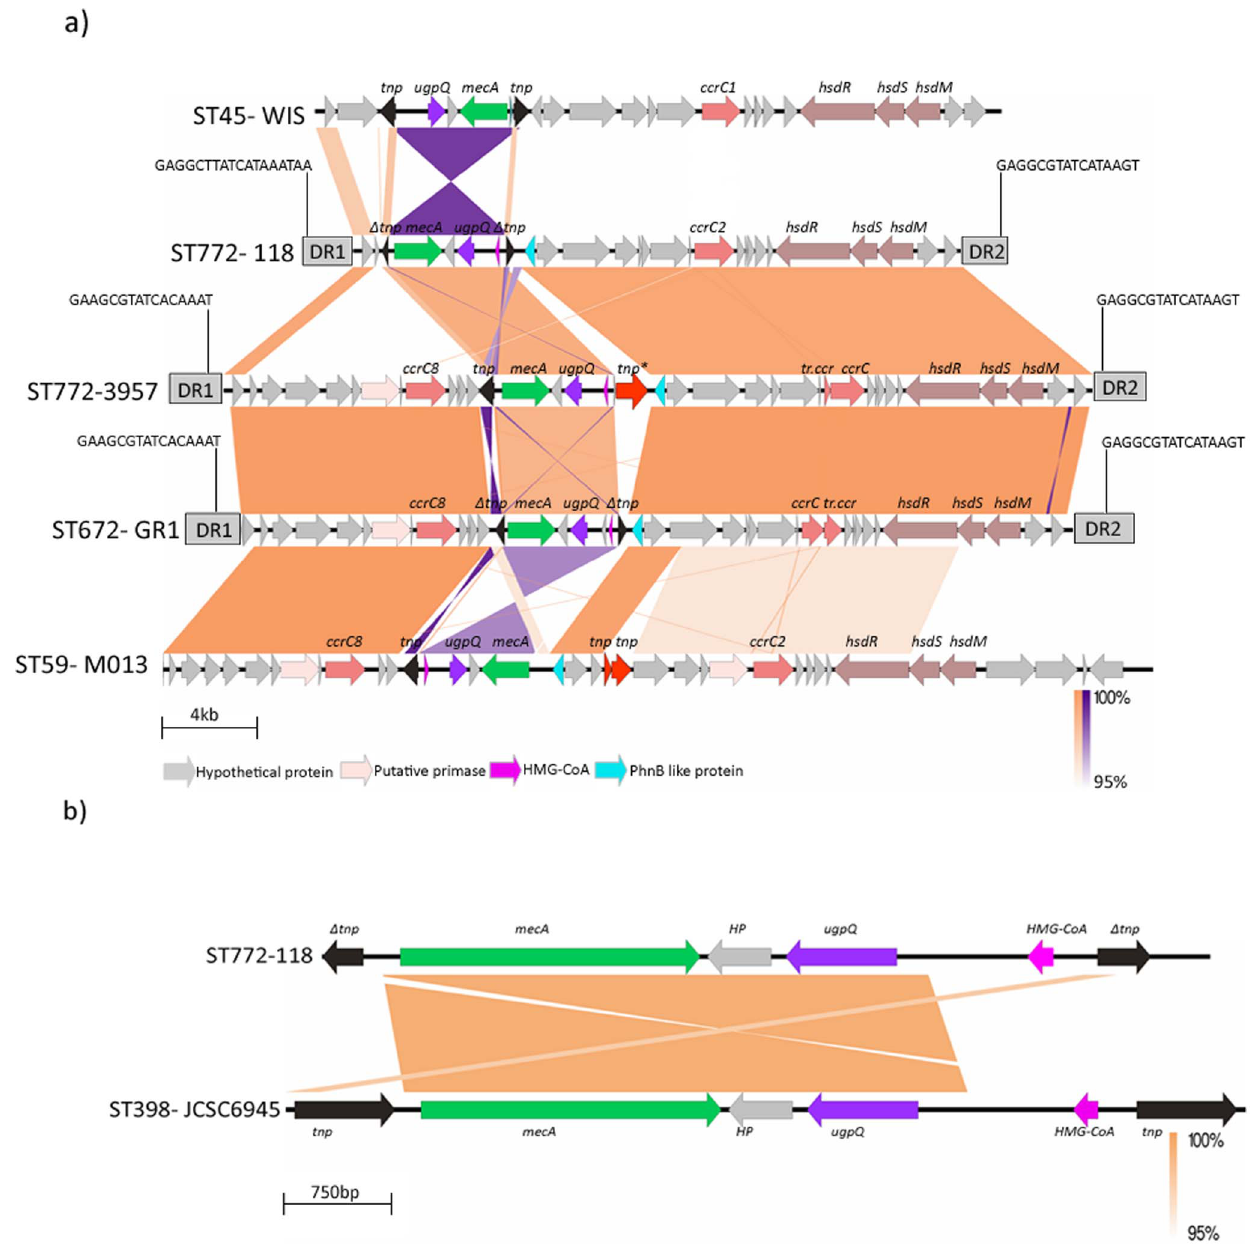
Figure 1. Schematic representation of genetic structures of type V SCC mec elements. a) Schematic representation and comparison of genetic structures of type V (5C2) SCC mec element of 118 (ST772), and type V (5C2&5) SCC mec elements of 3957 (ST772) and GR1(ST672) and the reference strains WIS (ST45) and M013 (ST59). Structures of these elements are illustrated based on nucleotide sequences deposited in DDBJ/EMBL/ GenBank database under the accession numbers AB777516, AB781446, AB781448, AB121219 and CP003166. Coding sequences are marked in the direction of transcription as arrows. Transposases for IS431 are indicated in black arrows. Intact transposases for IS431 have been labeled as tnp , truncated transposases for IS431 have been labeled as D tnp . Tranposase for IS1181and transposase for M013 are indicated in red arrows and have been labeled as tnp* and tnp , respectively. Color coding for the genes not labeled are shown in the legend. Conserved region with more than 95% homology are indicated in light brown and mec gene complex inversions are shown in purple as determined by BLASTN. Genomic picture was generated using Easy Fig software. 1b: Comparison of mec gene complexes in S. aureus 118 and JCSC6945.